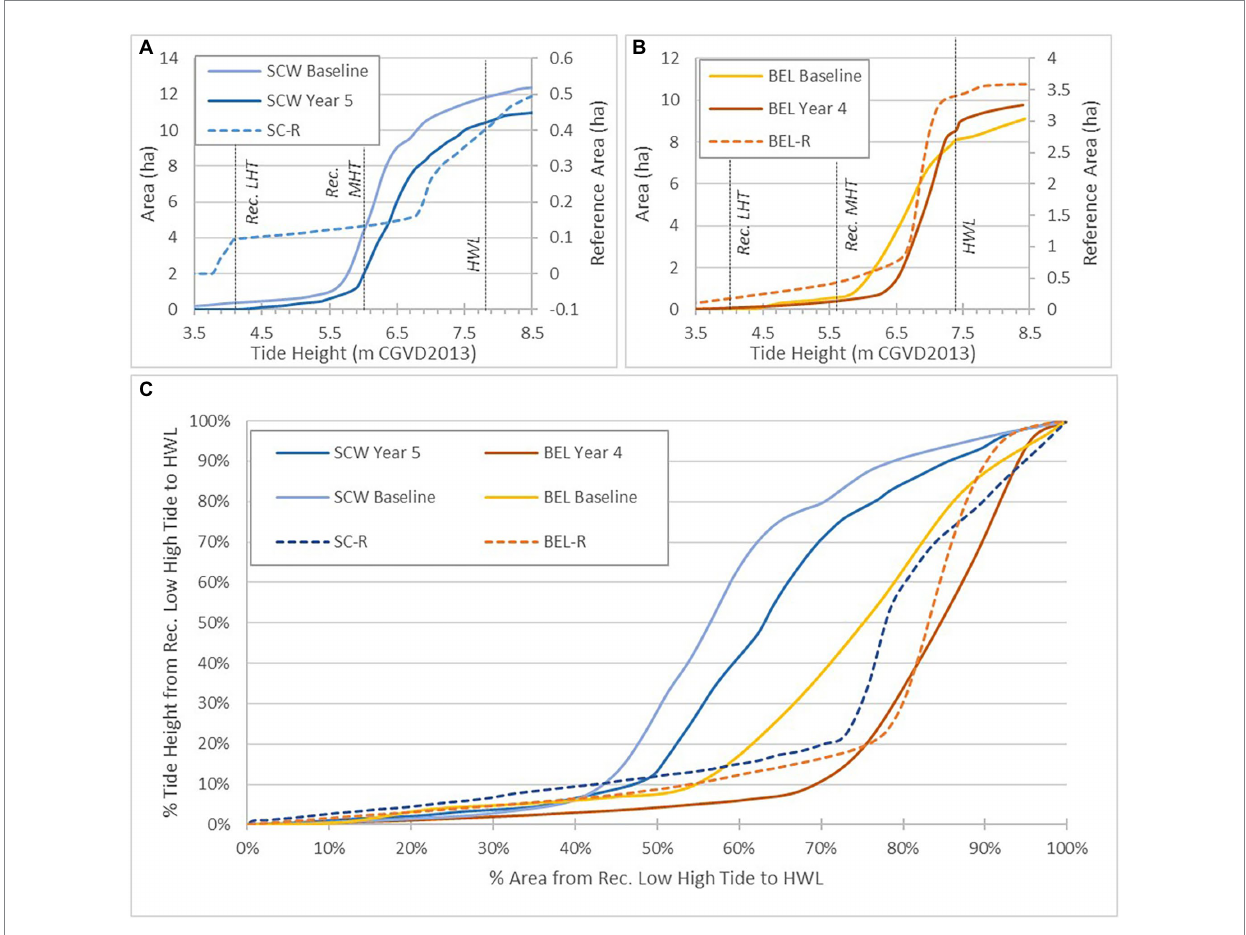
FIGURE 5 (A) SC hypsometric curves at reference site, pre, post restoration. (B) BEL hypsometric curves at reference site, pre, post restoration. (C) Area flooded (%) between recorded low high tide and HWL for SC and